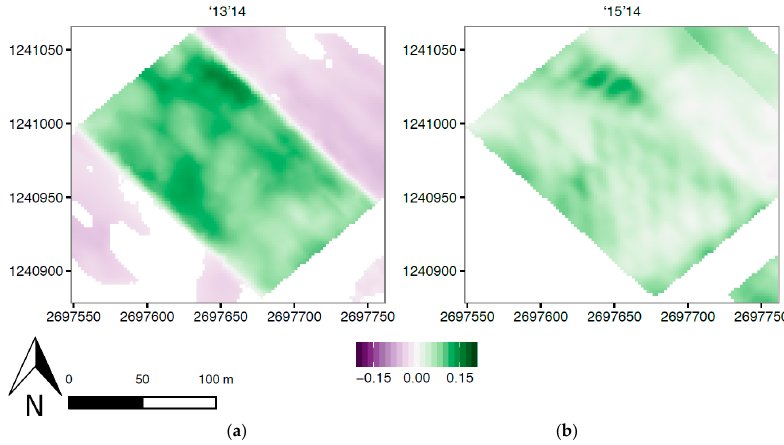
Figure 8. SMPE values for: ‘13’14 ( a ); and ‘15’14 ( b ) for an individual agricultural.